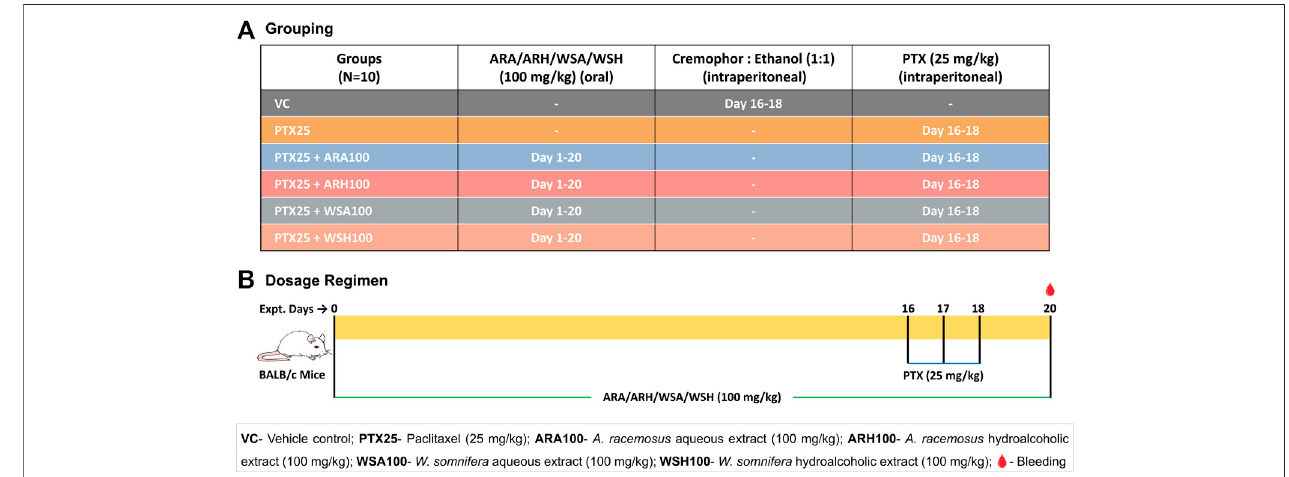
FIGURE 1 | Grouping and dosage regimen. (A) depicts grouping of mice to be dosed with botanical extracts and PTX for desired days. (B) illustrates the dosing regimen of botanical extracts as per Ayurveda (for 20 days) and that of PTX (on 16th, 17th and 18th day) as standardized for induction of myelosuppression. The blood samples were collected from retro-orbital plexus on 20th day for cell count and cytokine